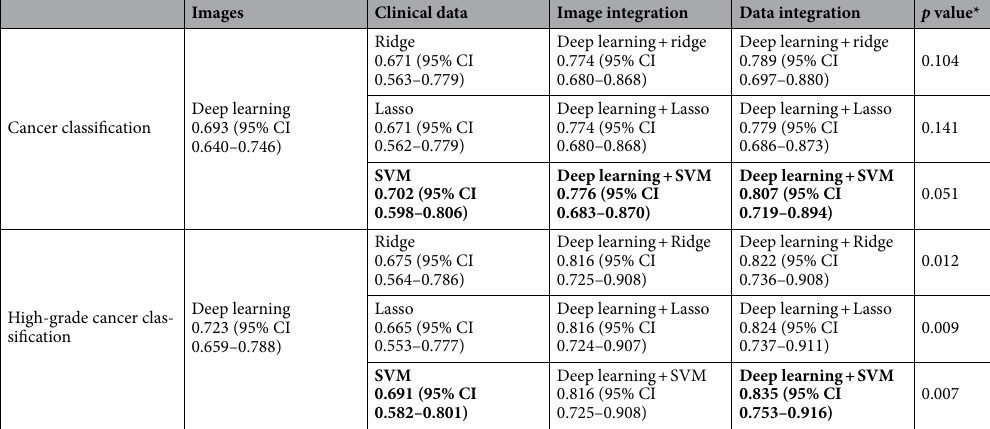
Table 2. AUCs of the cancer grading classification (n = 691). The bold text indicates the highest value of AUCs. AUC area under the curve, CI confidence interval, SVM support vector machine. *AUC of clinical data versus that of data